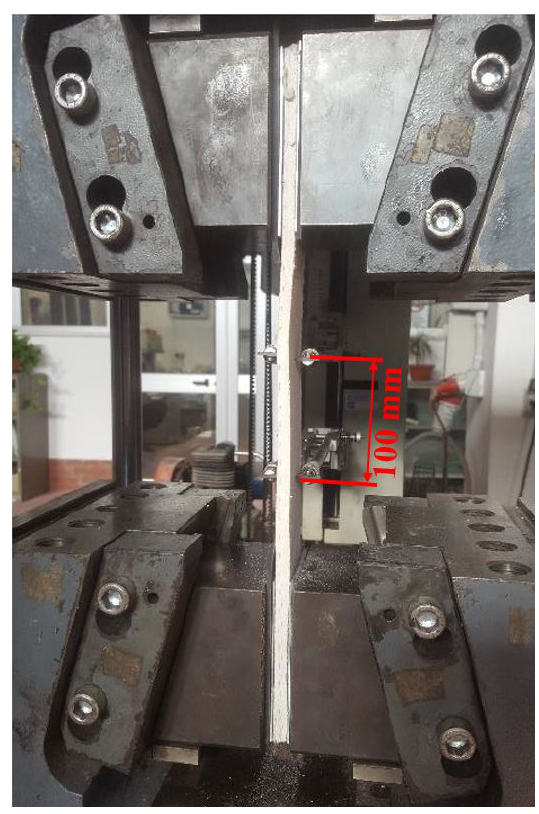
Figure 3. Set-up of uniaxial tensile